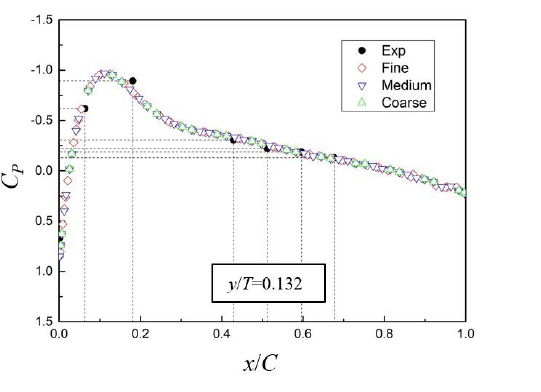
Figure 2. Mean C p calculated by SLA-IDDES: y / T = ( a ) 0.132 and ( b ) 1.726.